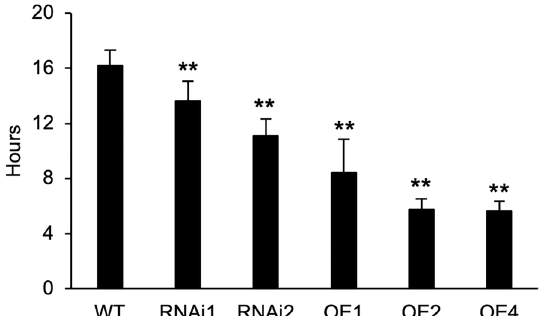
Fig. 8 Bending time of 6‑week‑old CWPO‑C transgenics and WT poplar. Bending time refers to the time (h) required for the stem to return to standing at 90° from being placed horizontally. Mean